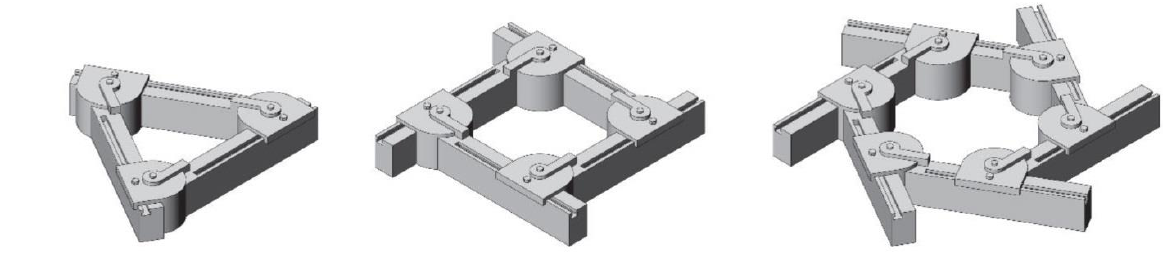
Fig. 14 Moulds with adjustable edge lengths and interior angles for triangular, quadrangular and hexagonal shapes.